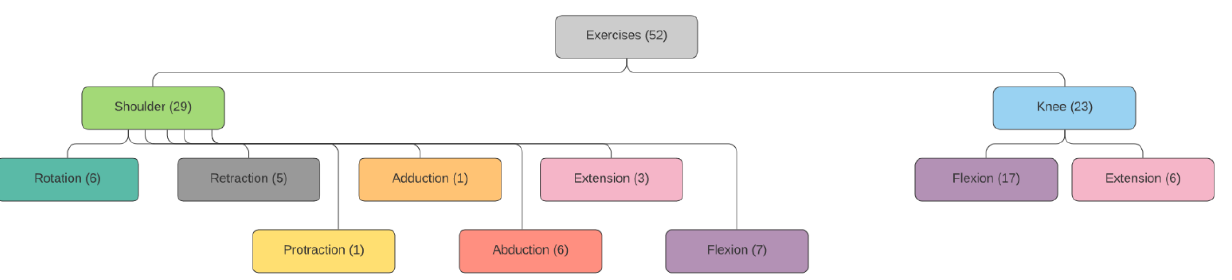
Figure 13. Correction of the position of the knees during the execution of the squat exercise.